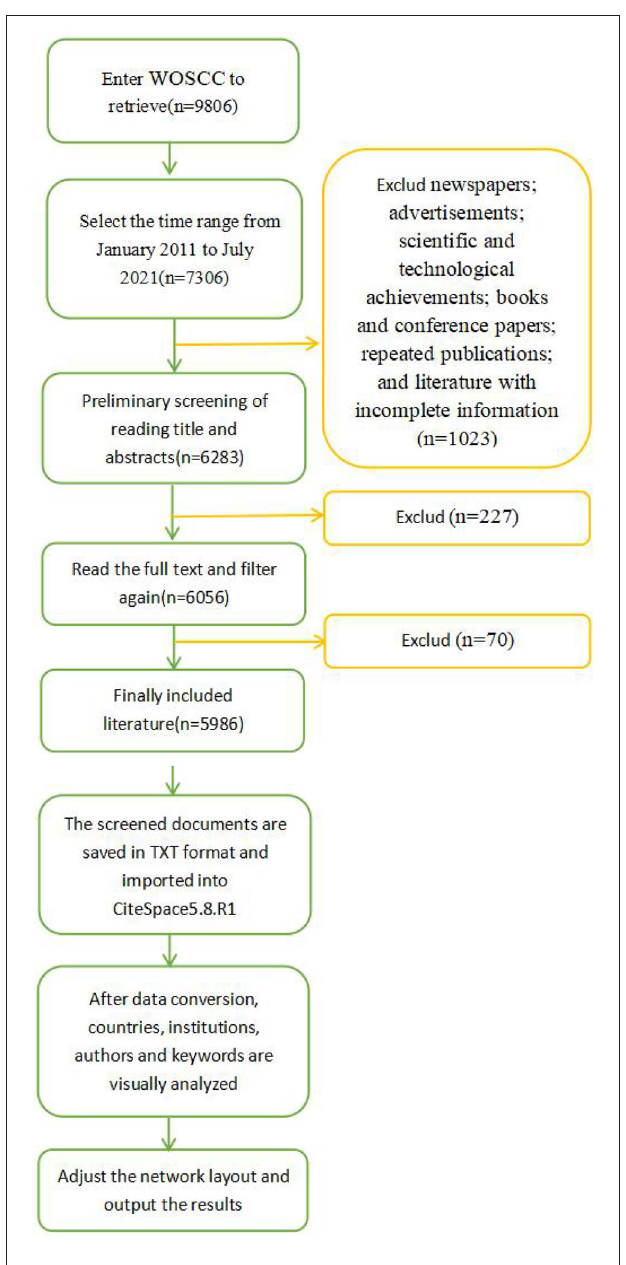
FIGURE 1 | Visual analysis flow chart of ECMO research field.